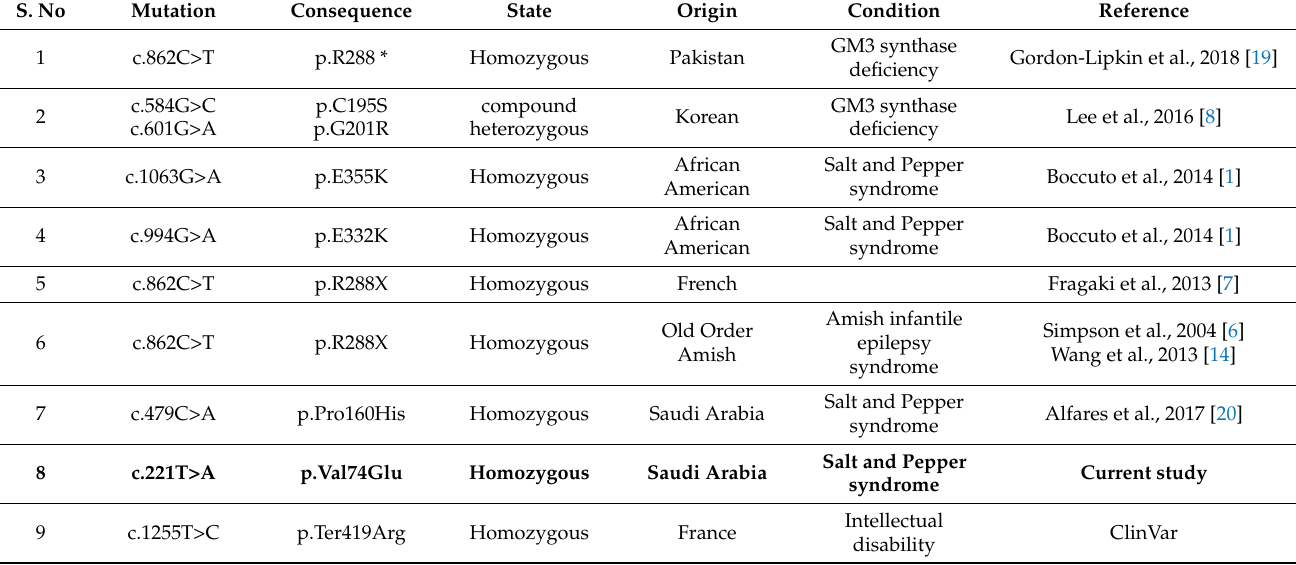
Table 1. Pathogenic mutations in ST3GAL5 gene so far in literature and available